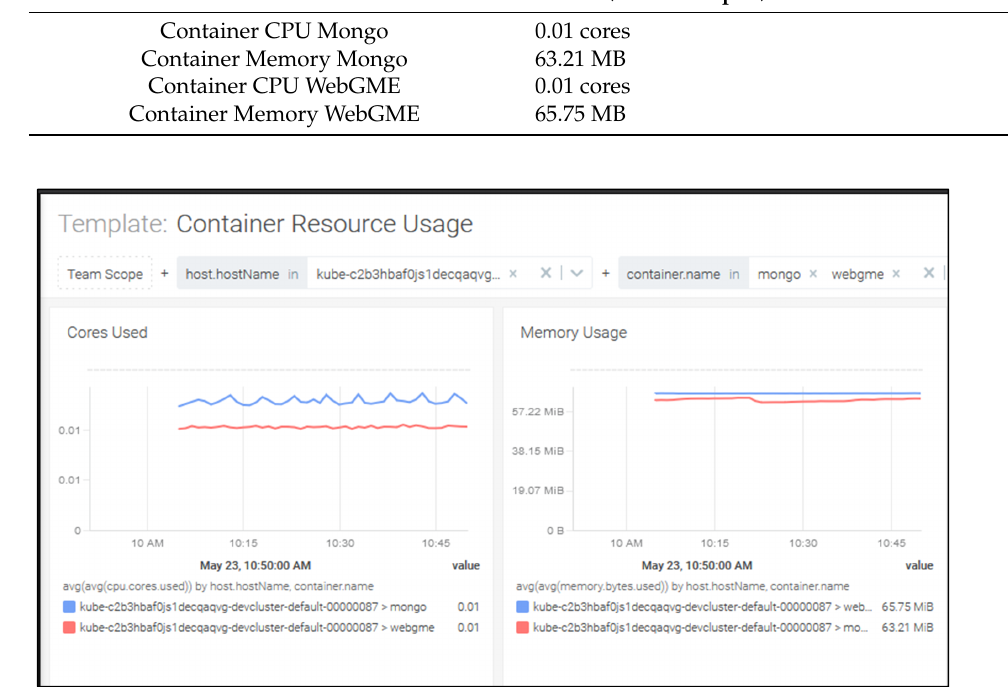
Table 12. Sysdig monitoring results for containers.